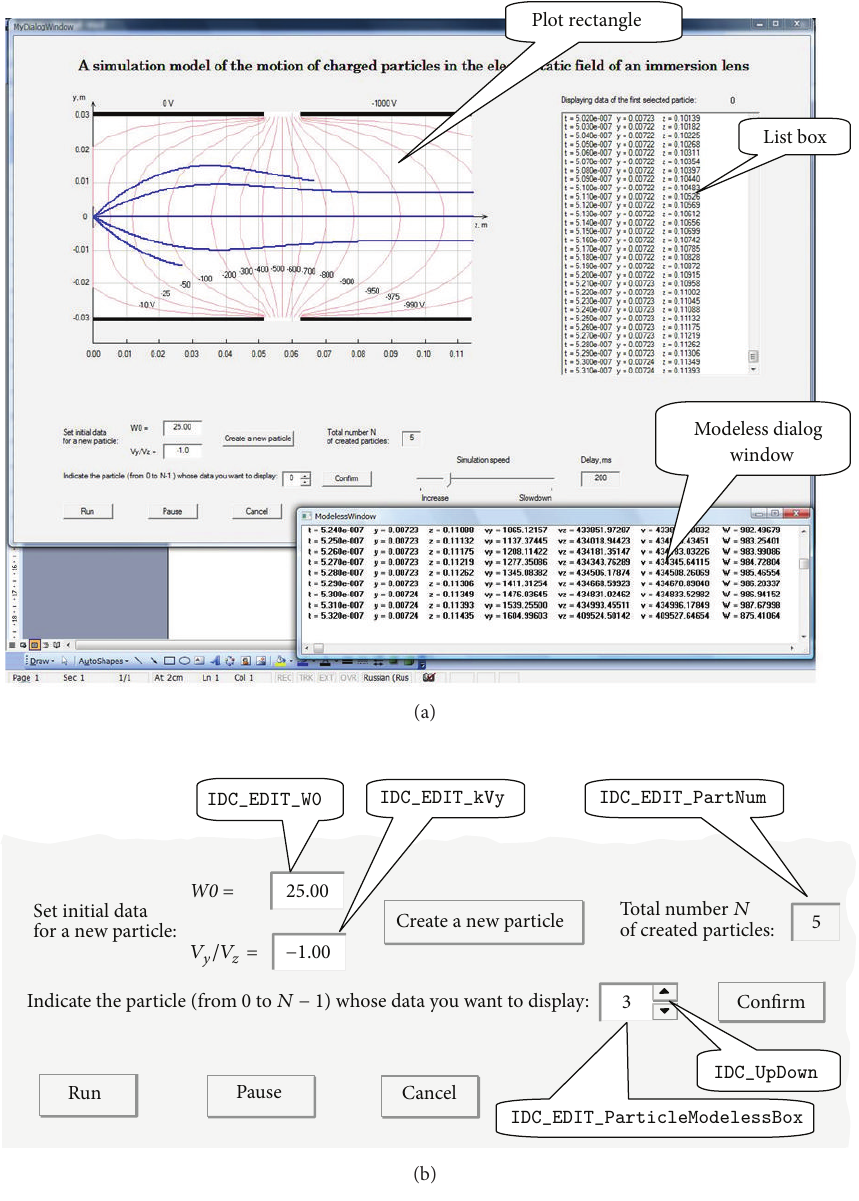
Figure 2: Screenshot of the graphic user interface (a) and a magnified view of the part of modal dialog box with control items (b).